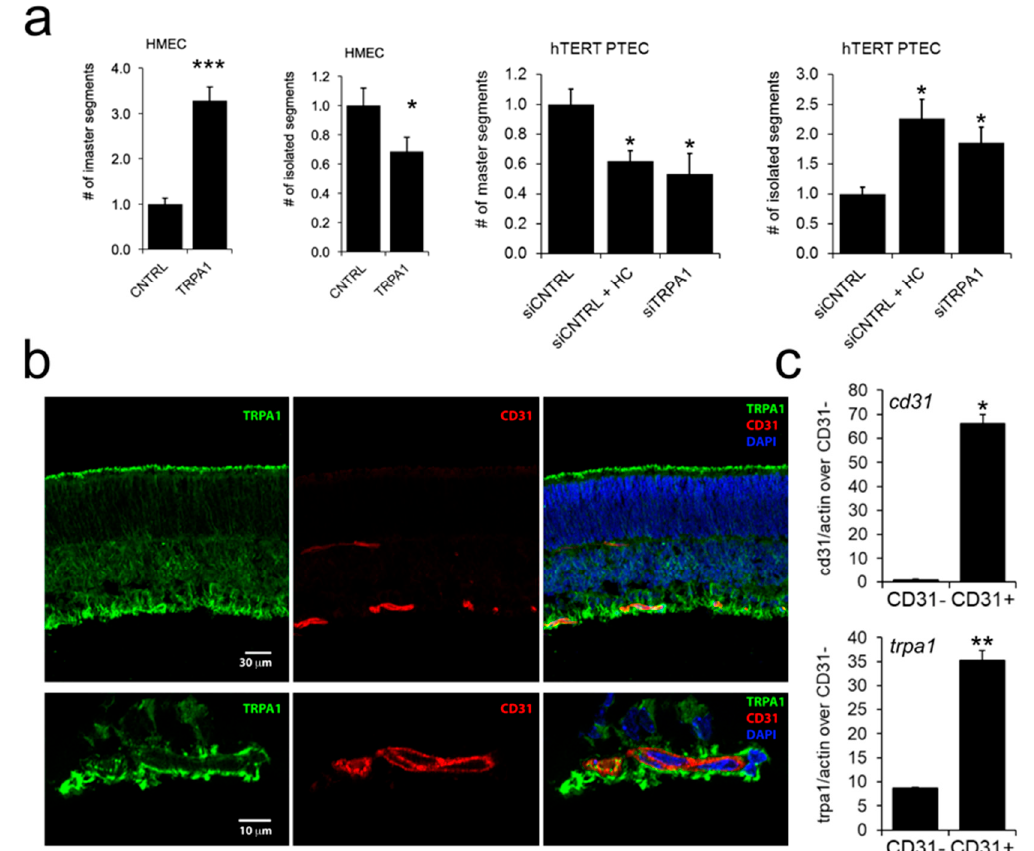
Figure 7. Figure 7. Cont.